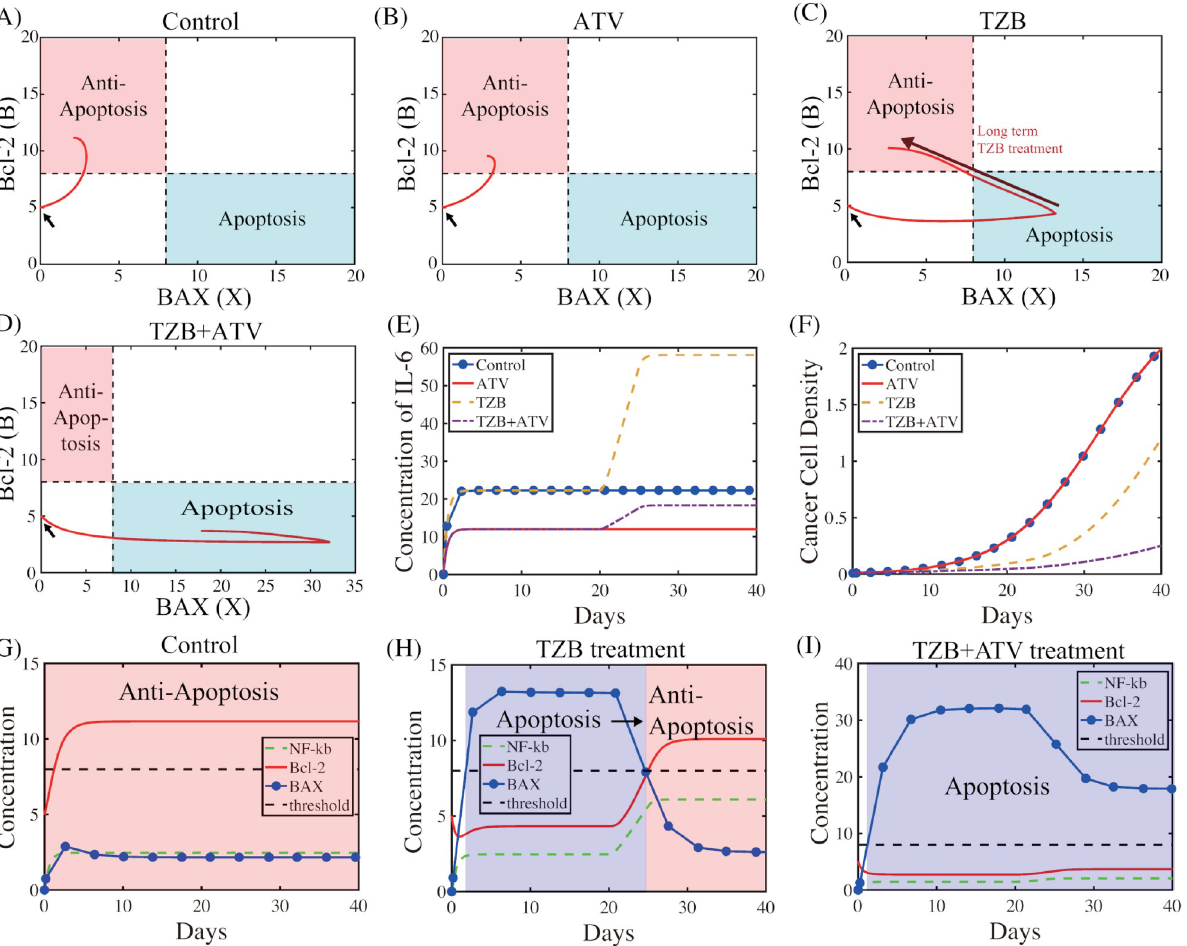
Fig 4. The role of TZB and ATV in regulation of the apoptosis control. (A-D) Trajectories of intracellular solutions ( X ( t ), B ( t )) in the X - B plane in response to control (TZB − ATV − ), ATV alone (TZB − ATV + ), TZB alone (TZB + ATV − ), and combination therapy (TZB + ATV + ). Initial condition (marked in black arrow): ( L (0), N (0), B (0), X (0), S (0), C (0)) = (0,0,5,0,0.25,0.01). Red arrow = transition of solutions from T treatment of TZB. (E,F) Time course of the IL-6 concentration (E) and tumor density (F) in response to four cases in (A-D). (G-I) Time courses of concentrations of three intracellular variables (NF κ B, Bcl-2, BAX) for control (G), TZB alone (H), and combination therapy (I),